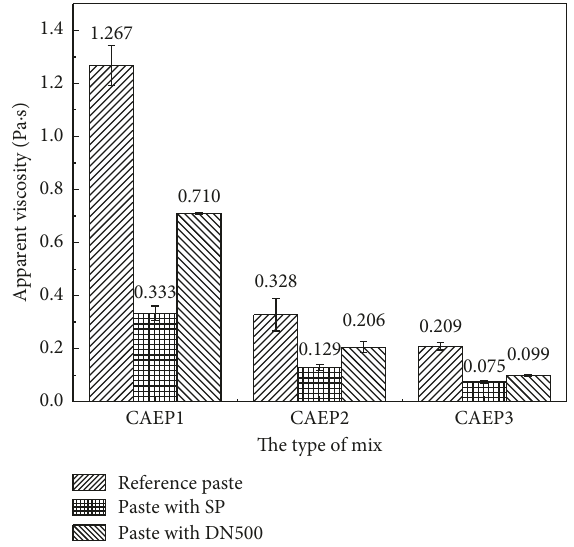
Figure 14: The apparent viscosity of CAEP with different